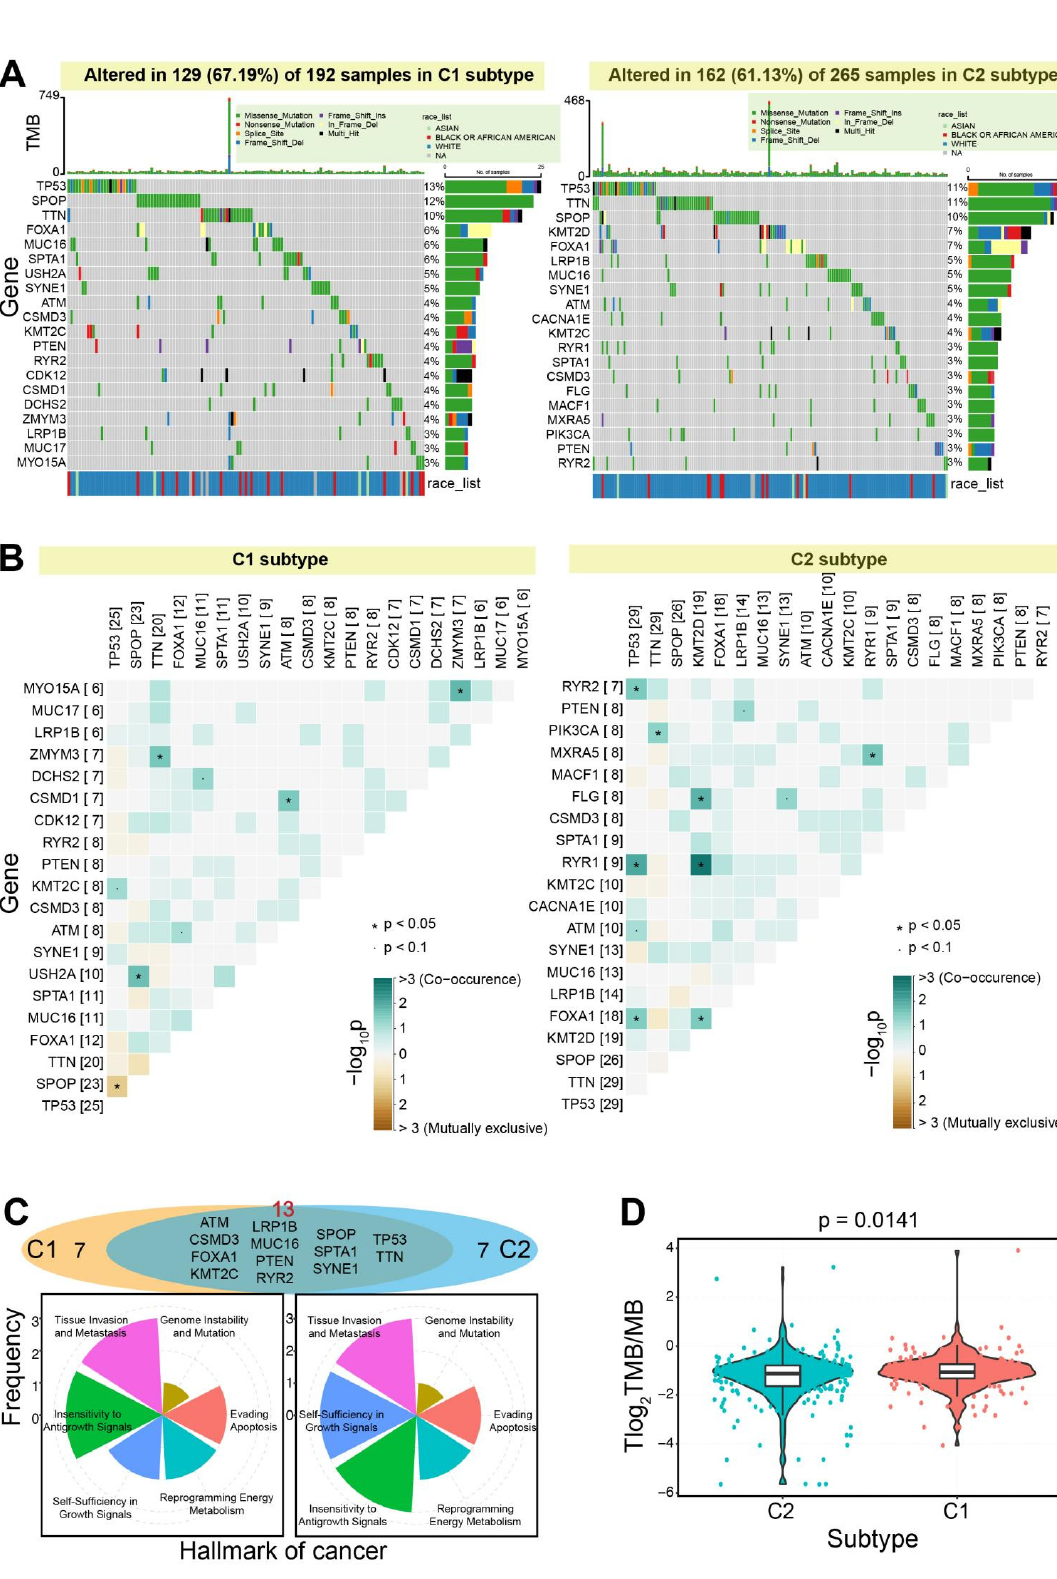
Figure 5. Somatic mutation landscapes of the two subtypes. ( A ). Somatic mutation landscapes of the two subtypes based on the top 20 genes with higher mutation frequencies, indicating the differences between the two subtypes. ( B ). Heatmaps show somatic interactions between the top 20 genes. ( C ). The gene distributions of the top 20 genes between the two subtypes and their potential contributions in hallmark of cancer. ( D ). The significant difference of the tumor mutational burden can be found between the two